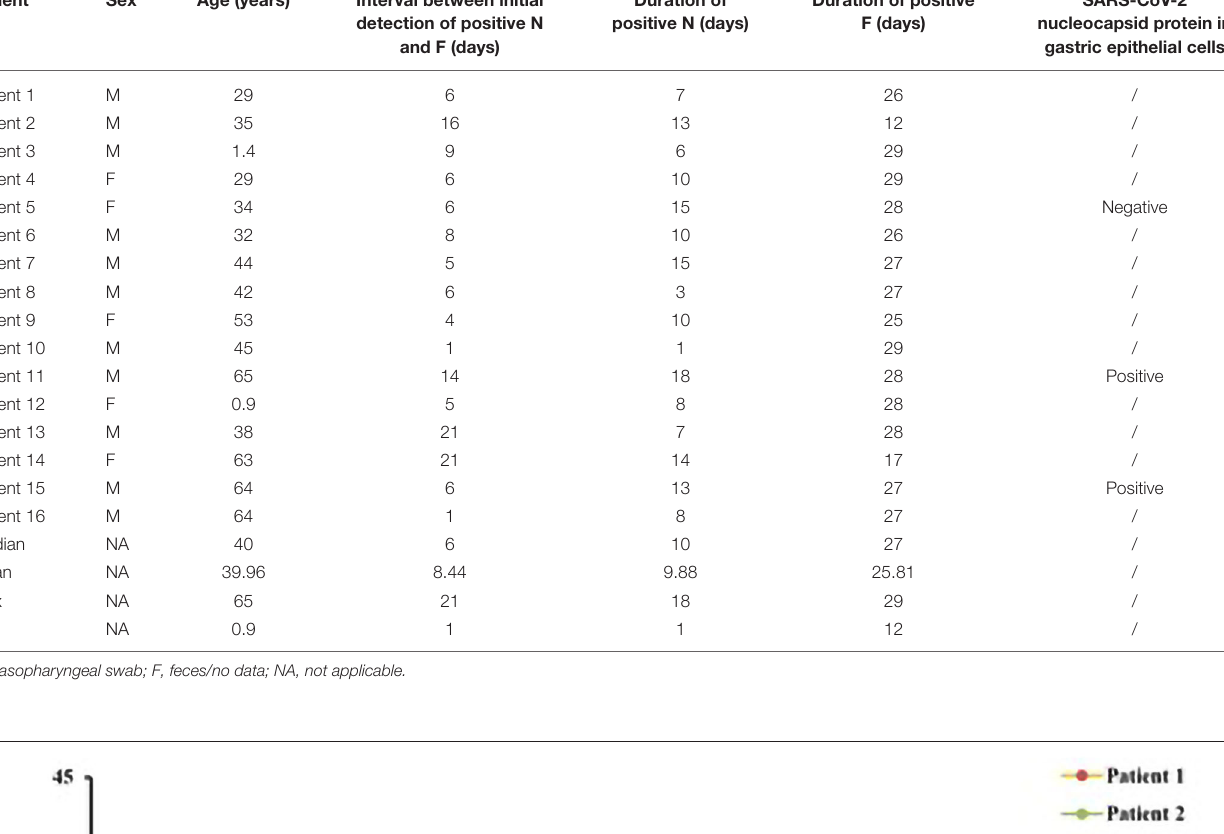
TABLE 2 | Clinical characteristics of patients with persistently positive SARS-CoV-2 RNA in feces. Patient Interval between initial